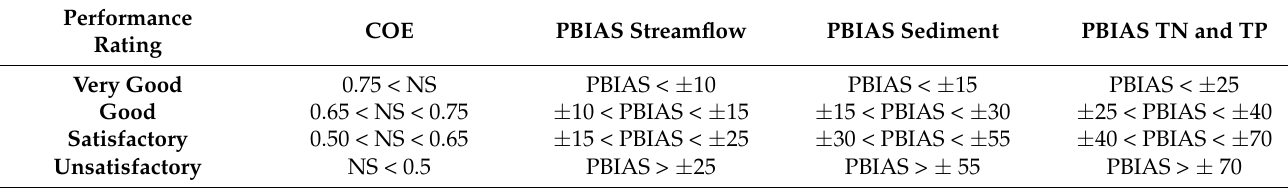
Table 3. Statistics range values for Nash–Sutcliffe efficiency (COE or NS) and percent bias (PBIAS) to compare for an indication of model performance